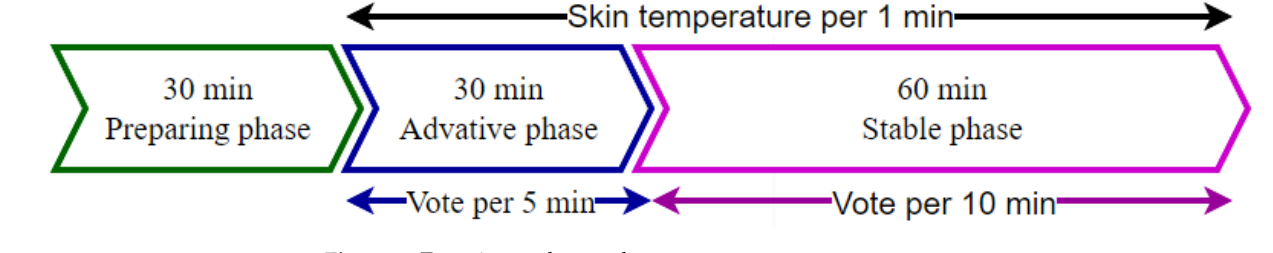
Figure 2. Experimental procedure.